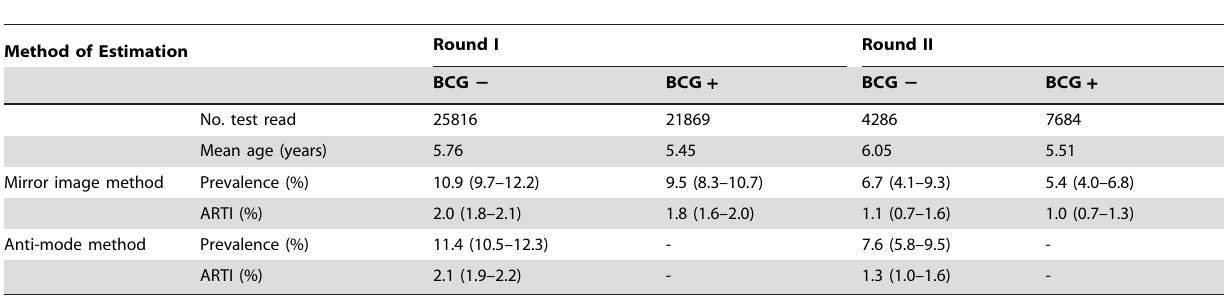
BCG 2 : children without BCG scar. BCG + : children with BCG